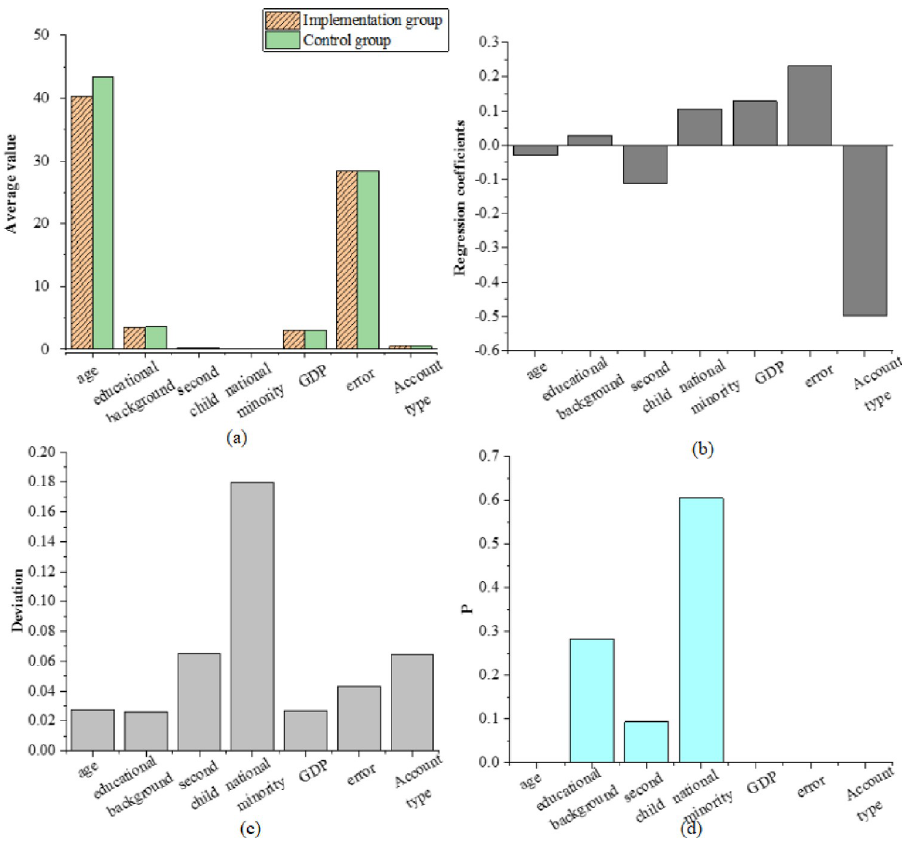
Fig 5. Matching results by nearest neighbor matching method (a) mean (b) regression coefficient (c) error (d) P.